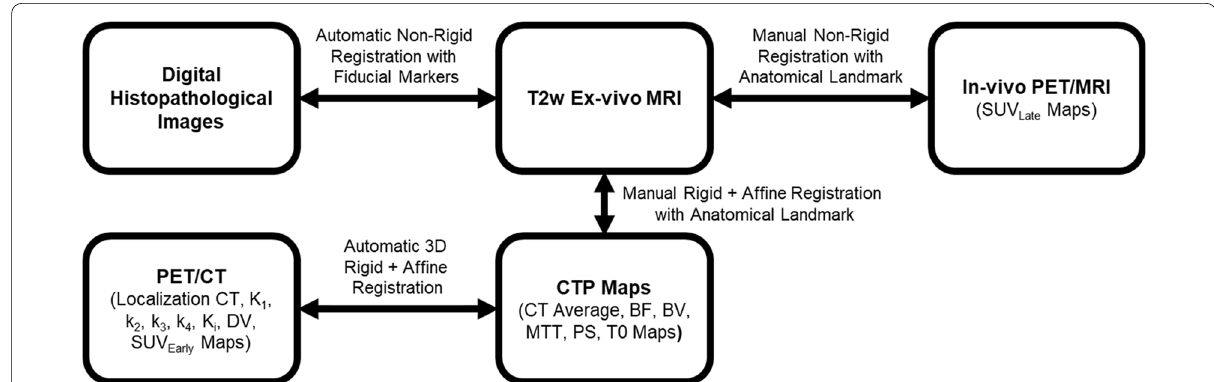
Fig. 1 Registration pipeline. CT Computed tomography, T2w transverse relaxation time weighted, PET positron emission tomography, MR magnetic resonance, BF blood flow, BV blood volume, MTT mean transit time, PS vessel permeability surface product, T o contrast delay time, K 1 influx rate constant, k 2 efflux rate constant, k 3 binding rate constant, k 4 dissociation rate constant, K i net uptake rate constant, DV distribution volume, SUV standardized uptake